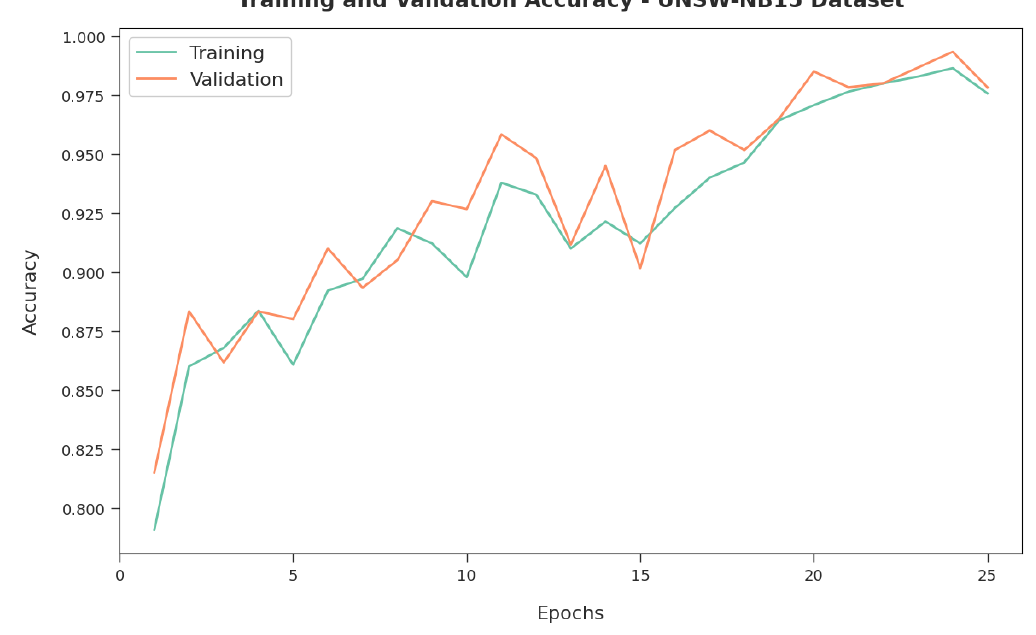
Figure 7. TA and VA analysis of OMLIDS-PBIoT technique under UNSW-NB15 dataset. The TL and VL achieved by the OMLIDS-PBIoT techniques on UNSW-NB15 dataset are established in Figure 8. The experimental outcome inferred that the OMLIDS-PBIoT technique has accomplished the least values of TL and VL. Specifically, the VL seemed to be less than TL.